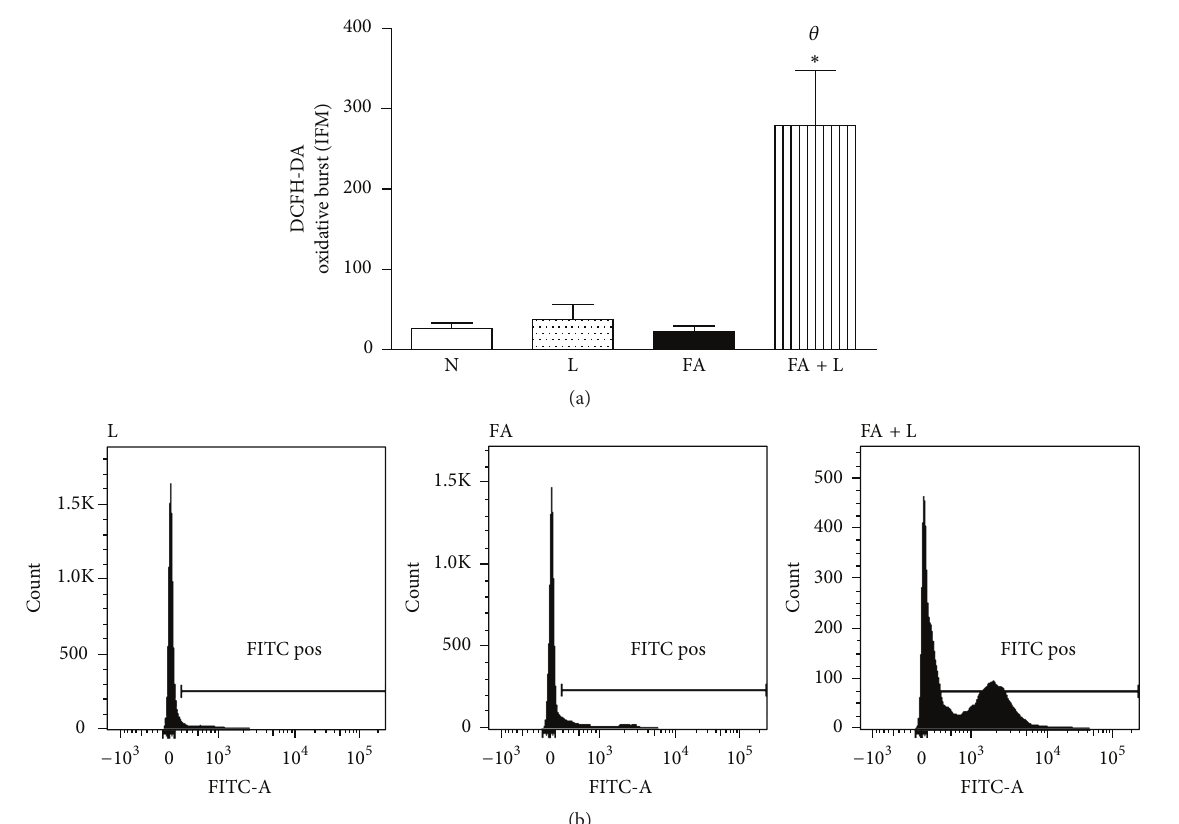
Figure 2: Photobiomodulation therapy increases oxidative burst in the lung. Group of rats was exposed to FA inhalation (1%, 90 min/day, 3 days) and treated or not with LLLT (30 mW, 1.8J, 60s/point, total 540 s, 1 and 5 h after each FA inhalation). In parallel, group of rats were treated only with laser and nonmanipulated rats were used to obtain basal parameters. The oxidative burst was determined 24 h after the last FA inhalation. Data mean ± SEM of 6 animals per group. ∗ 𝑃 < 0.05 in relation to N and L groups; 𝜃 𝑃 < 0.05 in relation to FA